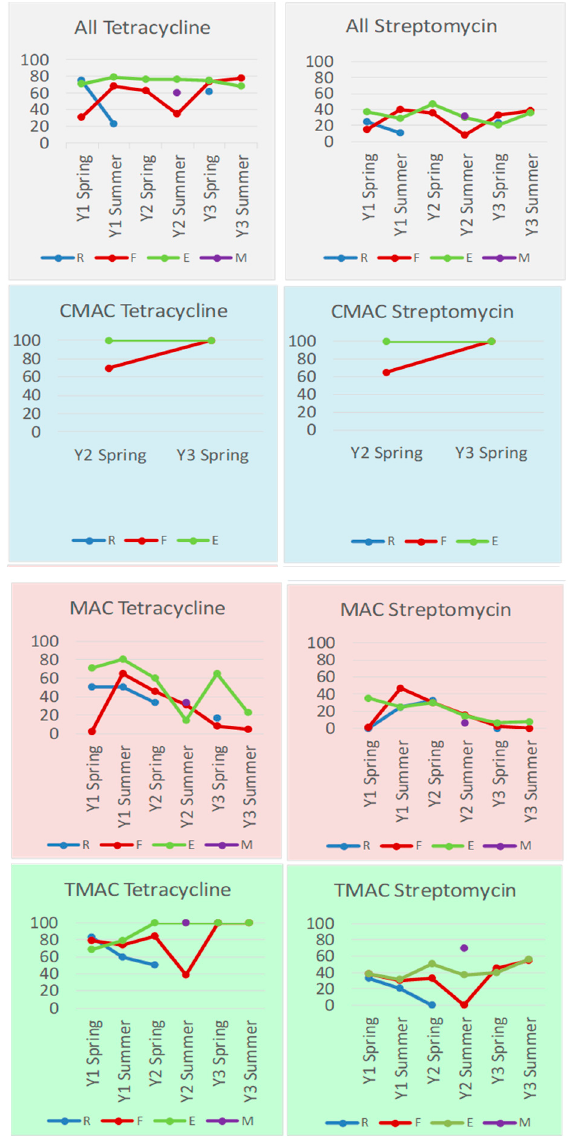
Figure 5. Percent of E. coli isolates phenotypically characterized as resistant to tetracycline and streptomycin, displayed by media from which they were initially isolated. MAC: n = 31, n = 293, and n = 120 for Rainfall Runoff (R), Feedlot Wastewater (F), and Excess Wastewater (E), respectively. For TMAC: n = 33, n = 293, and n = 141 for Rainfall Runoff, Feedlot Wastewater, and Excess Wastewater, respectively. For CMAC: n = 0, n = 26, and n = 5 for Rainfall Runoff, Feedlot Wastewater, and Excess Wastewater, respectively.